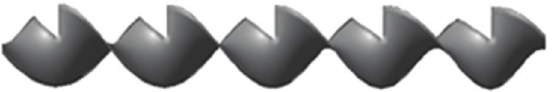
Figure 1: V-cut twisted tape insert.